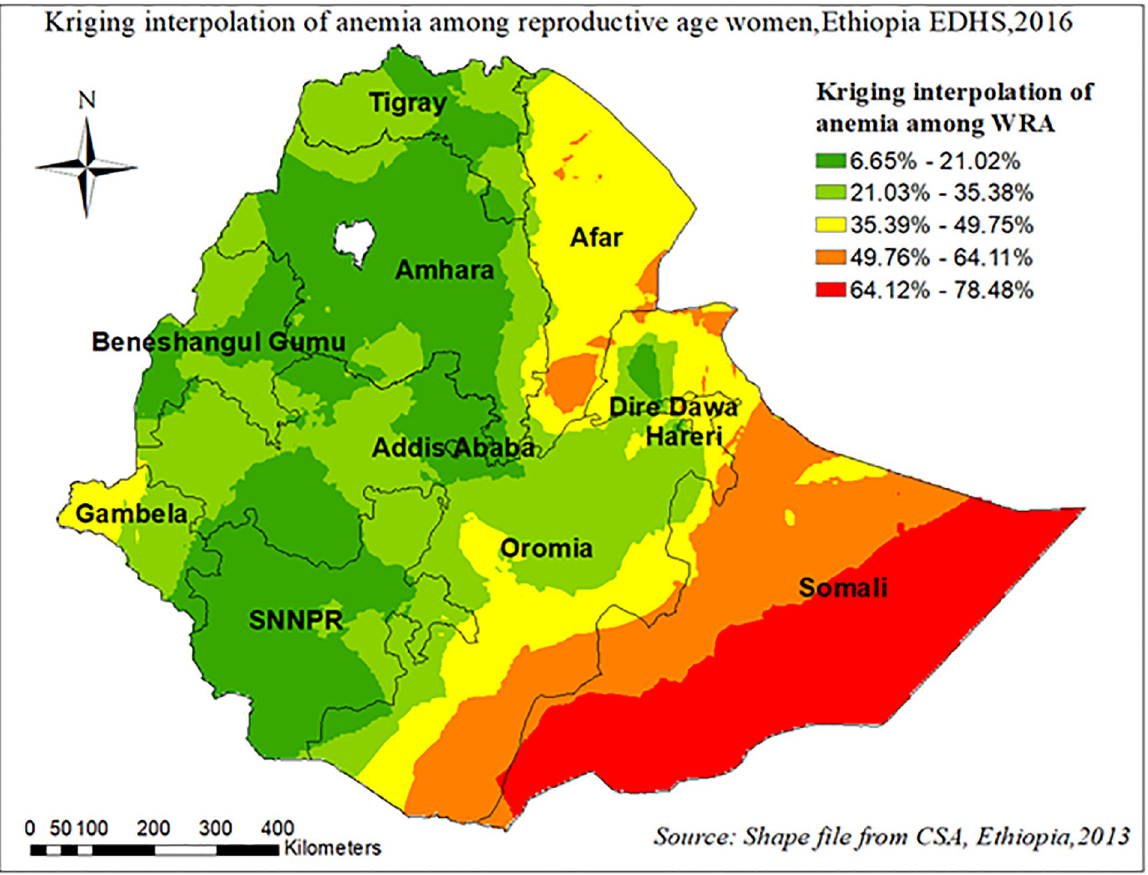
Fig 9. Kriging interpolation of anemia among reproductive age women in Ethiopia, EDHS 2016.